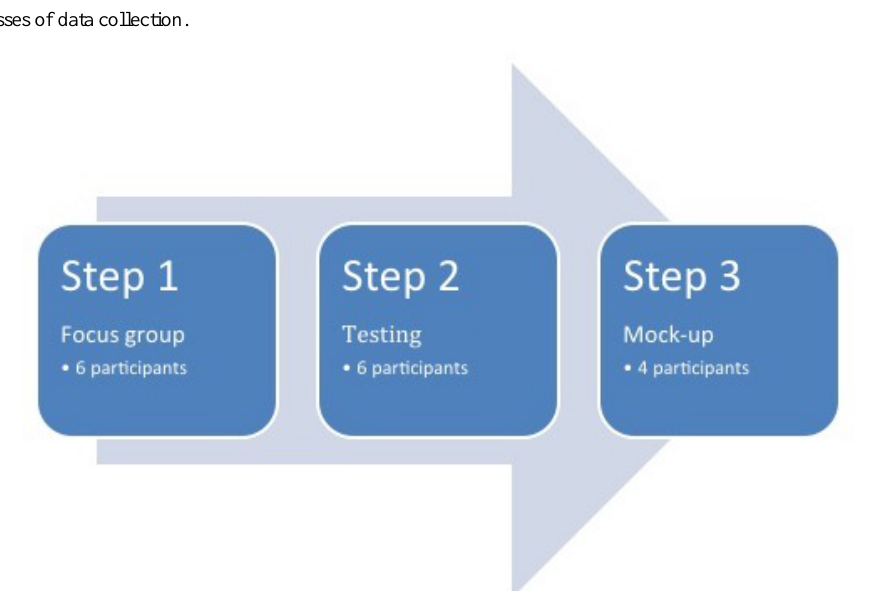
Figure 1. Three processes of data